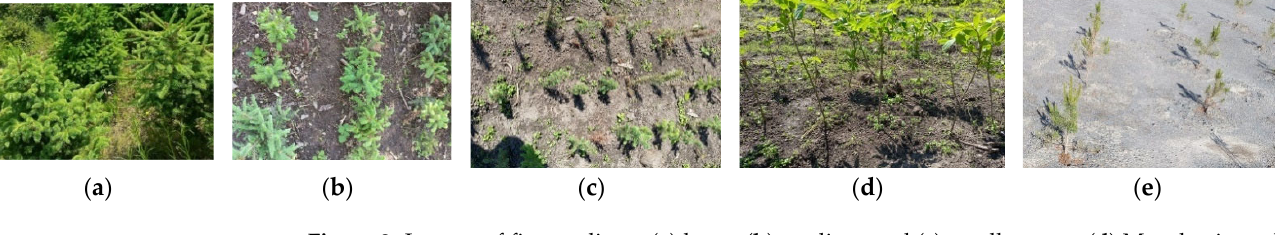
Table 1. Data augmentation dataset examples. X ‐ Axis Flip Y ‐ Axis Flip Salt Noise Gaussian Noise